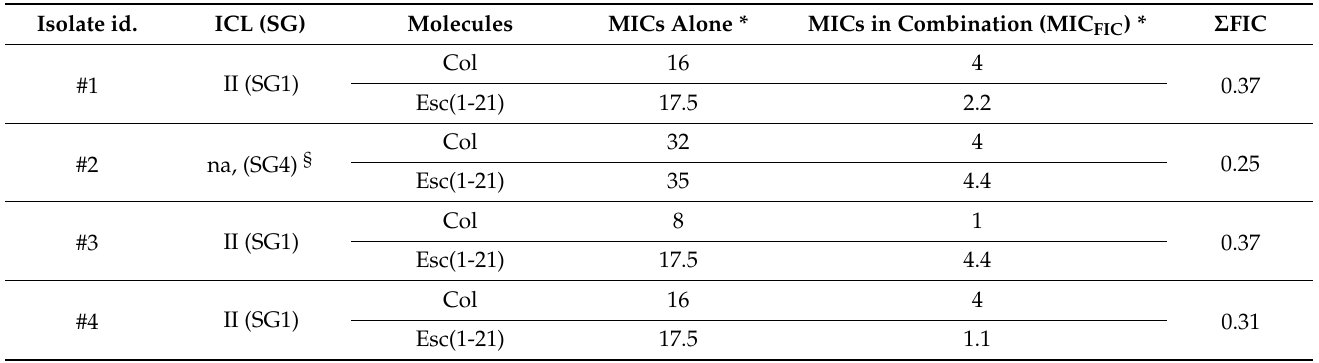
Table 1. MICs and combinatory effect of colistin (Col) and Esc(1-21) against the four A. baumannii strains and relation to clonal